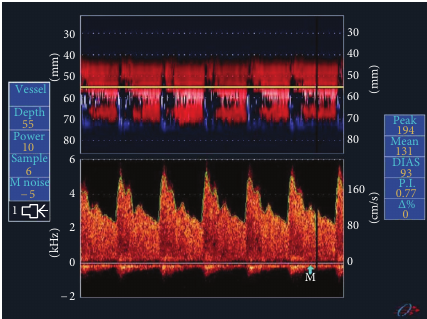
F 2: TCD. Doppler velocities demonstrating moderate MCA vasospasm using M mode (above) and pulse-wave Dopper (below). is �gure is reproduced from